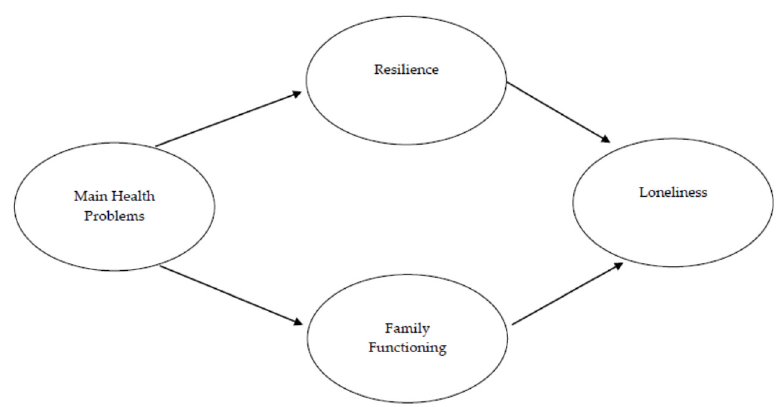
Figure 1. Hypothesized model.